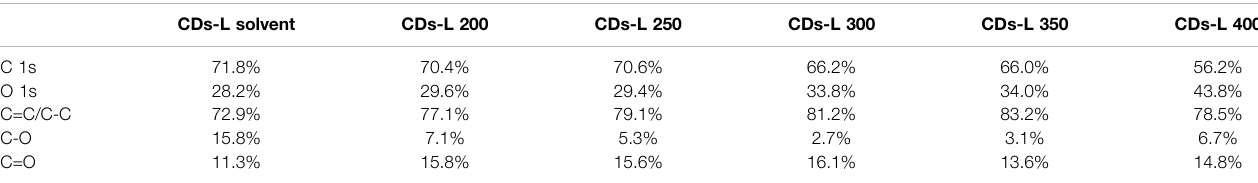
TABLE 2 | Elemental proportions and chemical bonds in lignin based